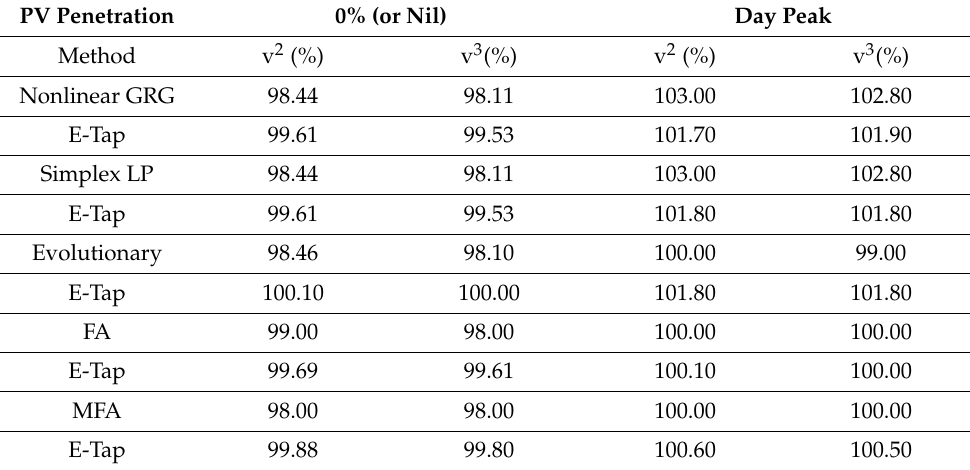
Table 10. Results of various optimization